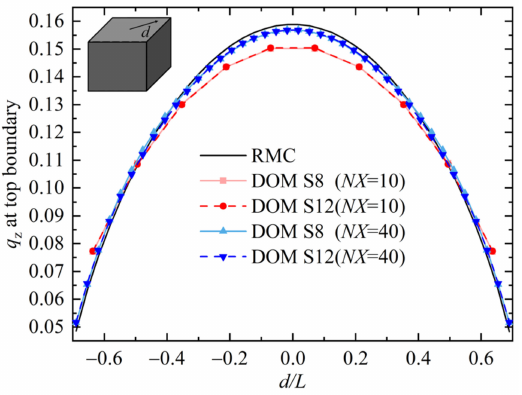
Figure 6. Heat flux by DOM with different angular and spatial discretization of Case 3.